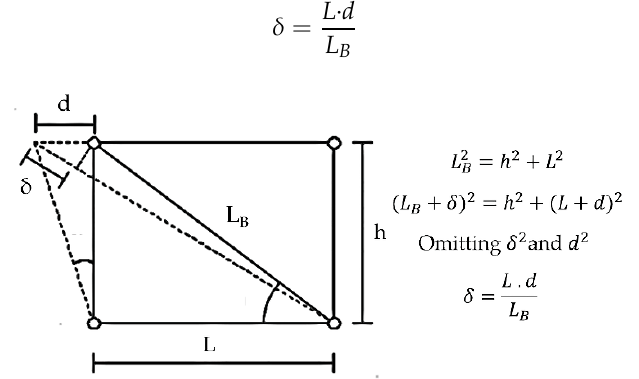
Figure 5. Story drift and brace axial displacement correlation.